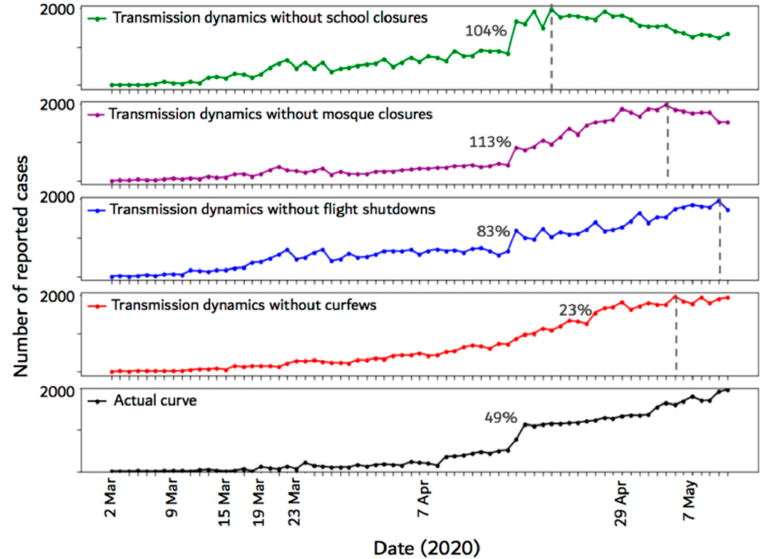
Figure 6. Epidemic curves resulting from not implementing each of the four major control measures employed by the Saudi government. The dashed vertical lines show the time step (day) at which the number of new cases reached the maximum. Each percentage represents the maximum percentage increase in the number of infected cases between any two time-steps on the curve.